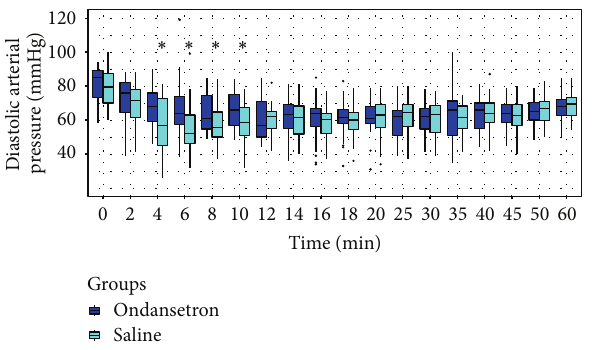
Figure 3: Trends of diastolic blood pressure (DAP). ∗ < 0.05